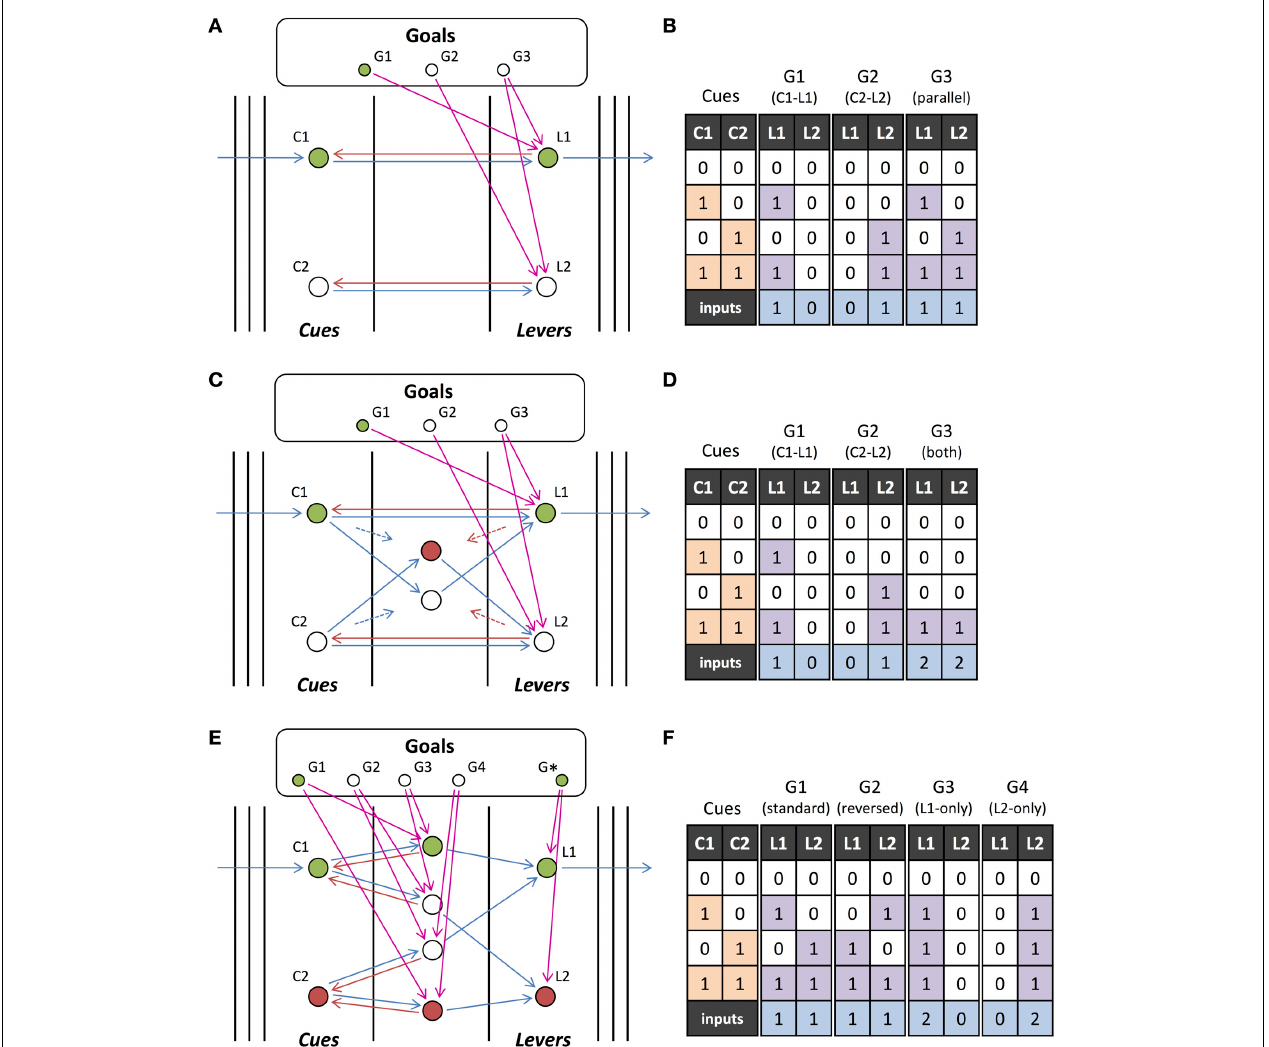
FIGURE 6 | Stimulus-response Tasks. (A) An example of how the cortical architecture would be utilized for a stimulus-response task where a subject pulls one of two levers when presented with one of two sensory cues. The task switches between one of three “goals”: lever L1 should be pulled for cue C1 and cue C2 ignored (G1), L2 for C2 and C1 ignored (G2), and L1 for C1 and L2 for C2 (G3). Network activity is shown for when G1 is active. Similarly, the arrows to the cue units from the left and those leaving the lever units depict the inputs and outputs of the network (i.e., only “active” connections) for a particular set of inputs. (B) Input-output tables for the network shown in (A) for the three different goals. The final row indicates the number of inputs